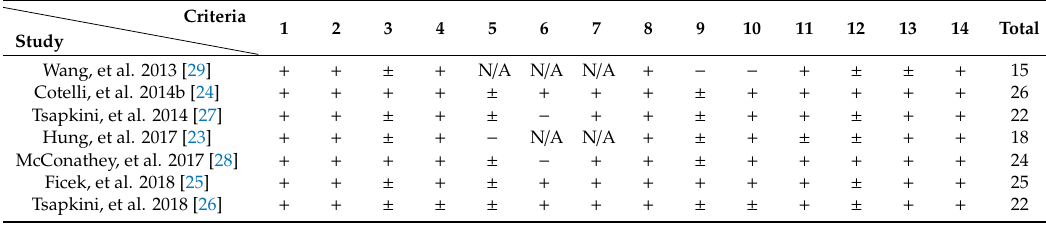
Table 1. Results of the publication’s quality